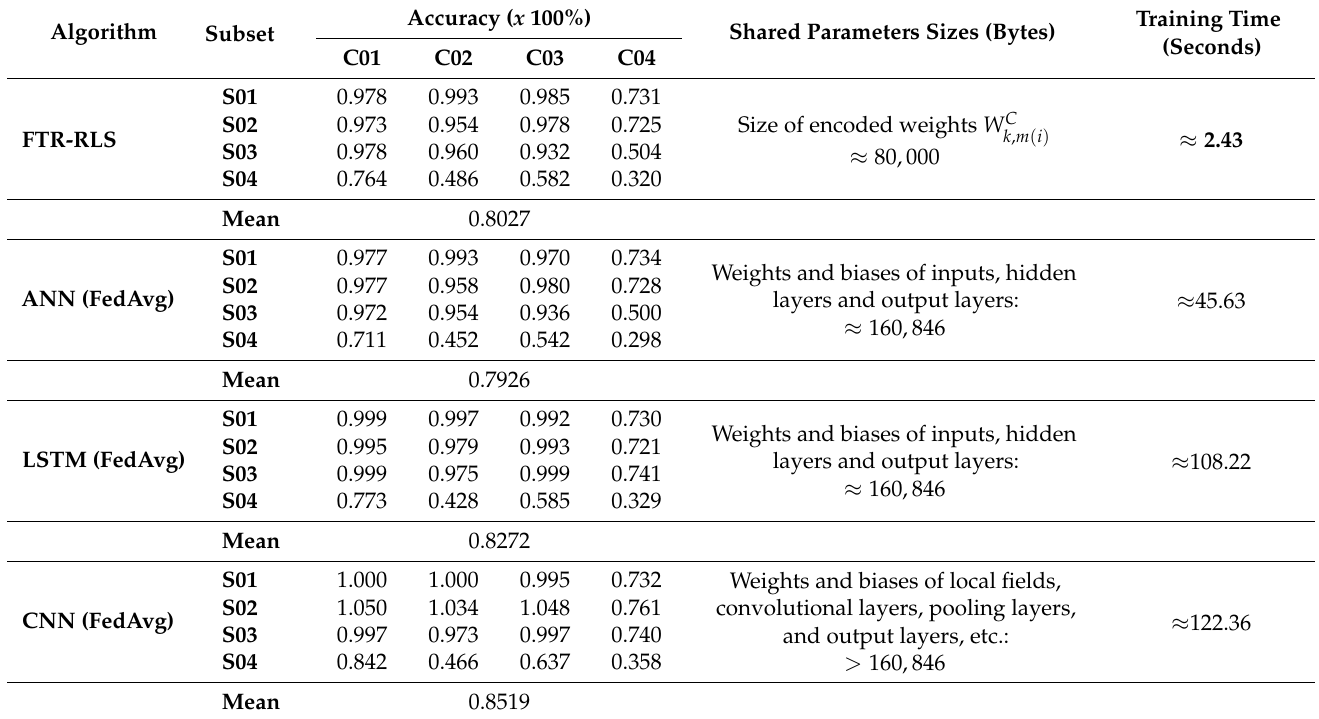
Table 4. Comparison of FL algorithms